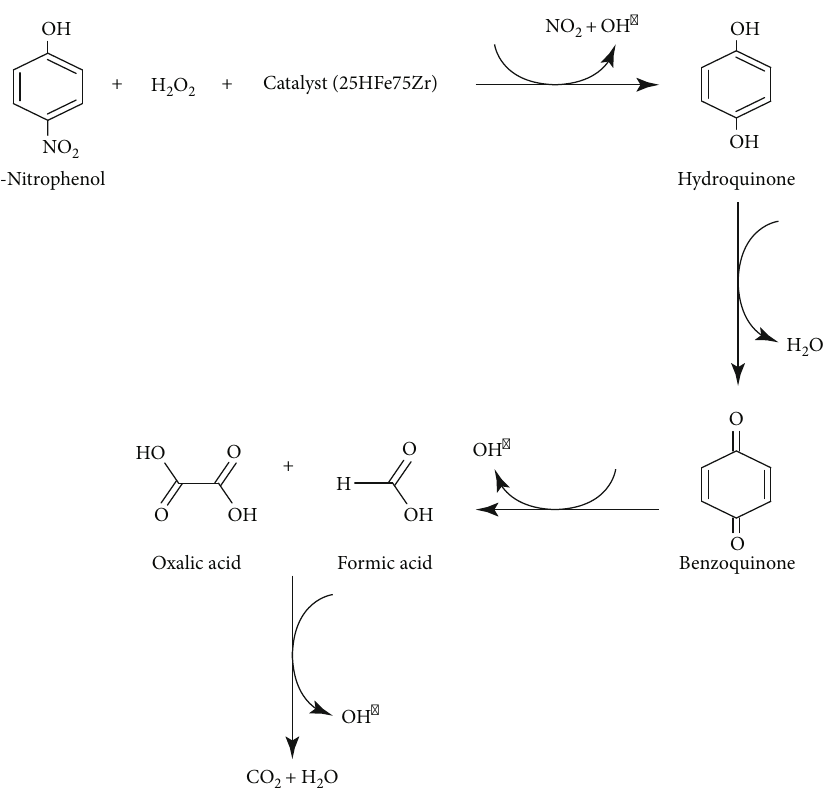
Figure 9: Illustration of degradation mechanism of 4-nitrophenol using the best catalyst obtained in this